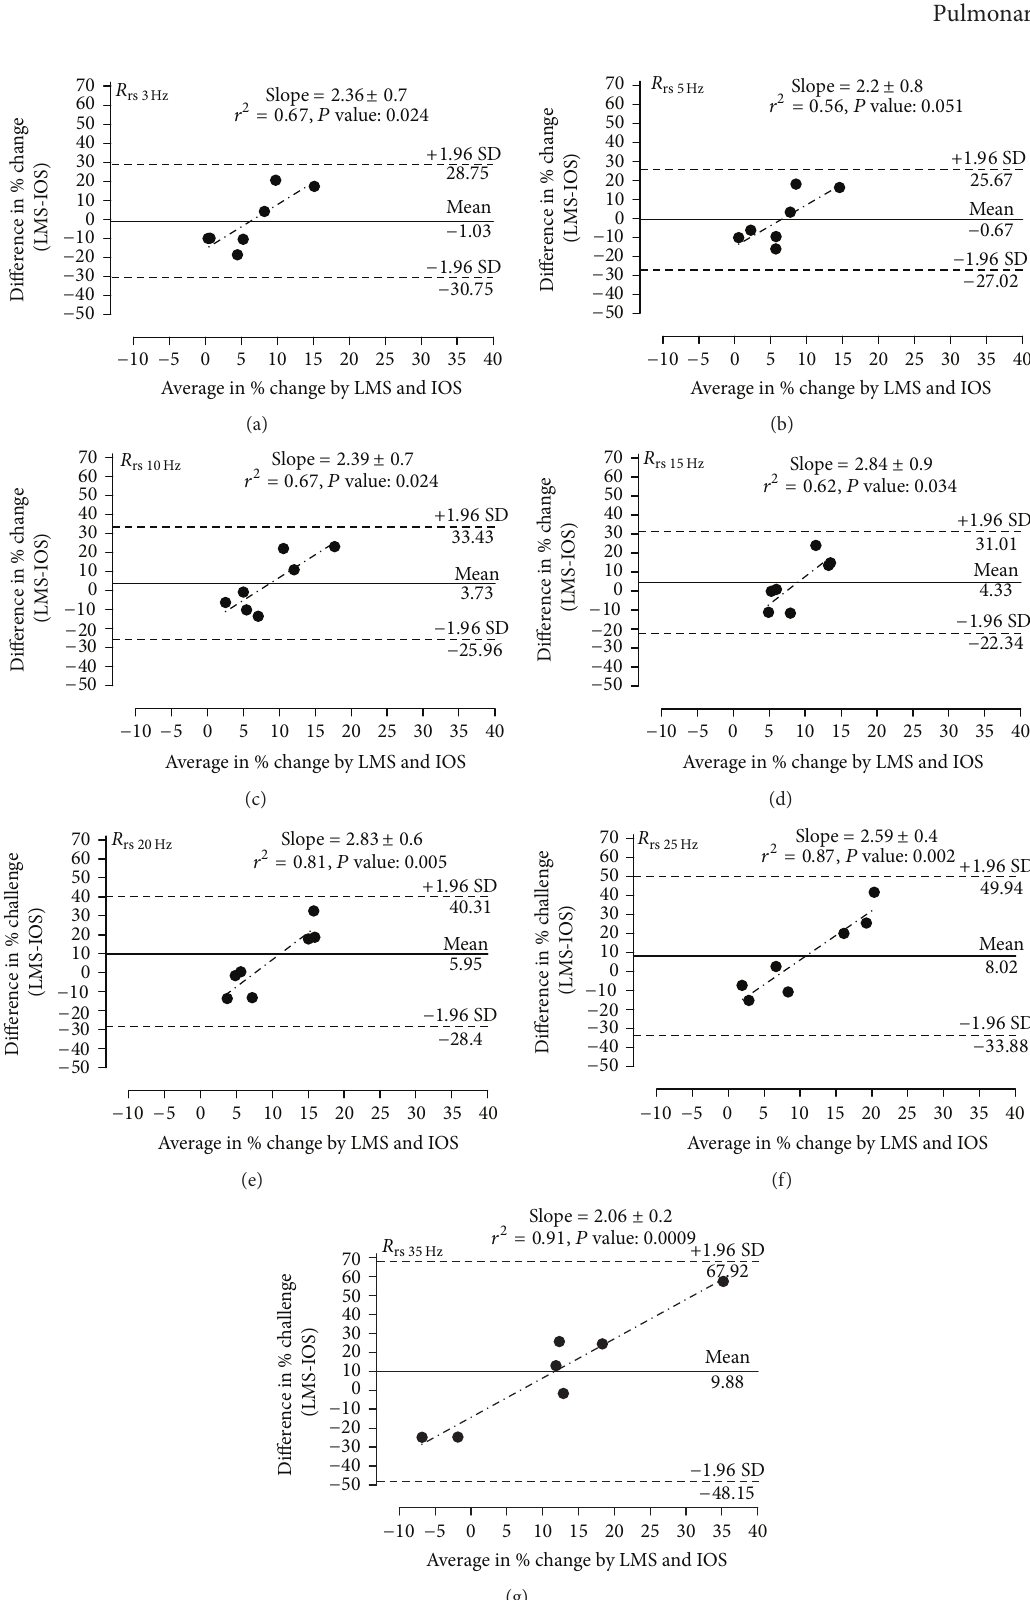
Figure 5: Bland-Altman plots constructed from the least mean square (LMS) and impulse oscillometry (IOS) data at each specific frequency (percentage of change) with mean (bias), ± LOA, and best-fit values of linear regression (slope, 𝑟 2 , 𝑃 value) after administration of intravenous bethanechol. LOA, limit of agreement; Upper LOA, mean difference (bias) + 1.96 SD; Lower LOA, mean difference (bias) − 1.96 SD; 𝑟 2 , 𝑅 squares. The 𝑃 value is testing the null hypothesis that the overall slope is